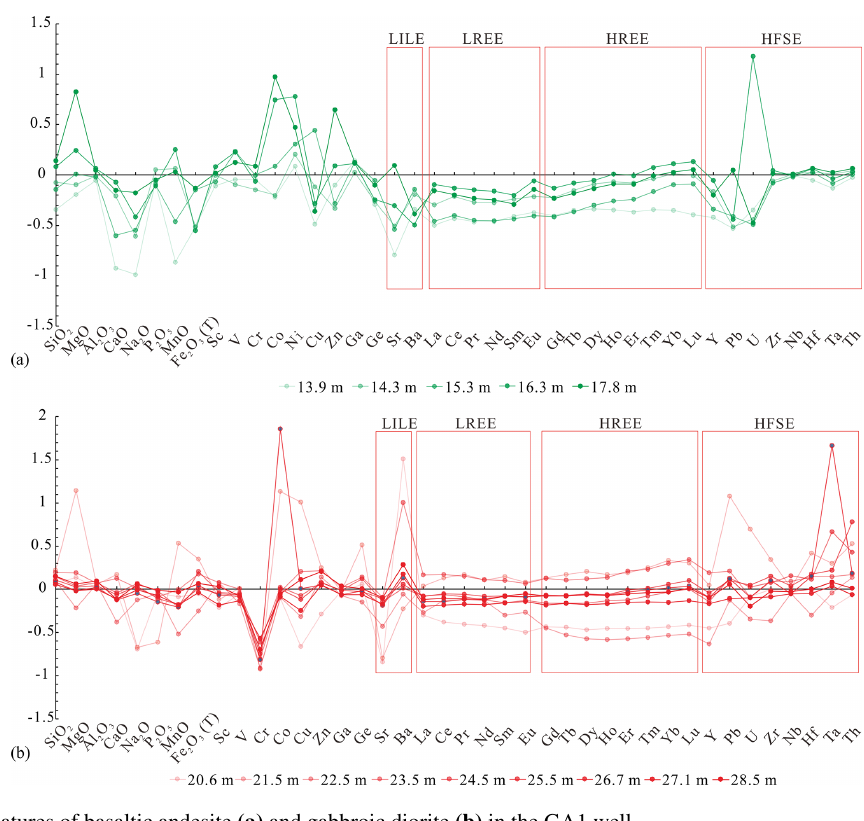
Figure 10. τ value features of basaltic andesite (a) and gabbroic diorite (b) in the GA1 well.